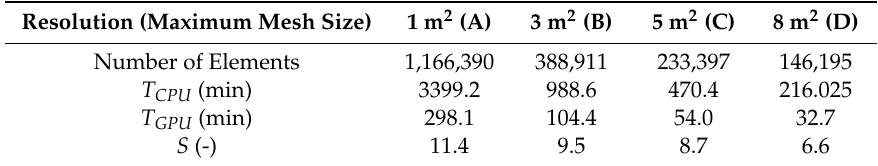
Table 2. Number of elements, CPU and GPU computational times and speedup ratio S for the simulations at di ff erent